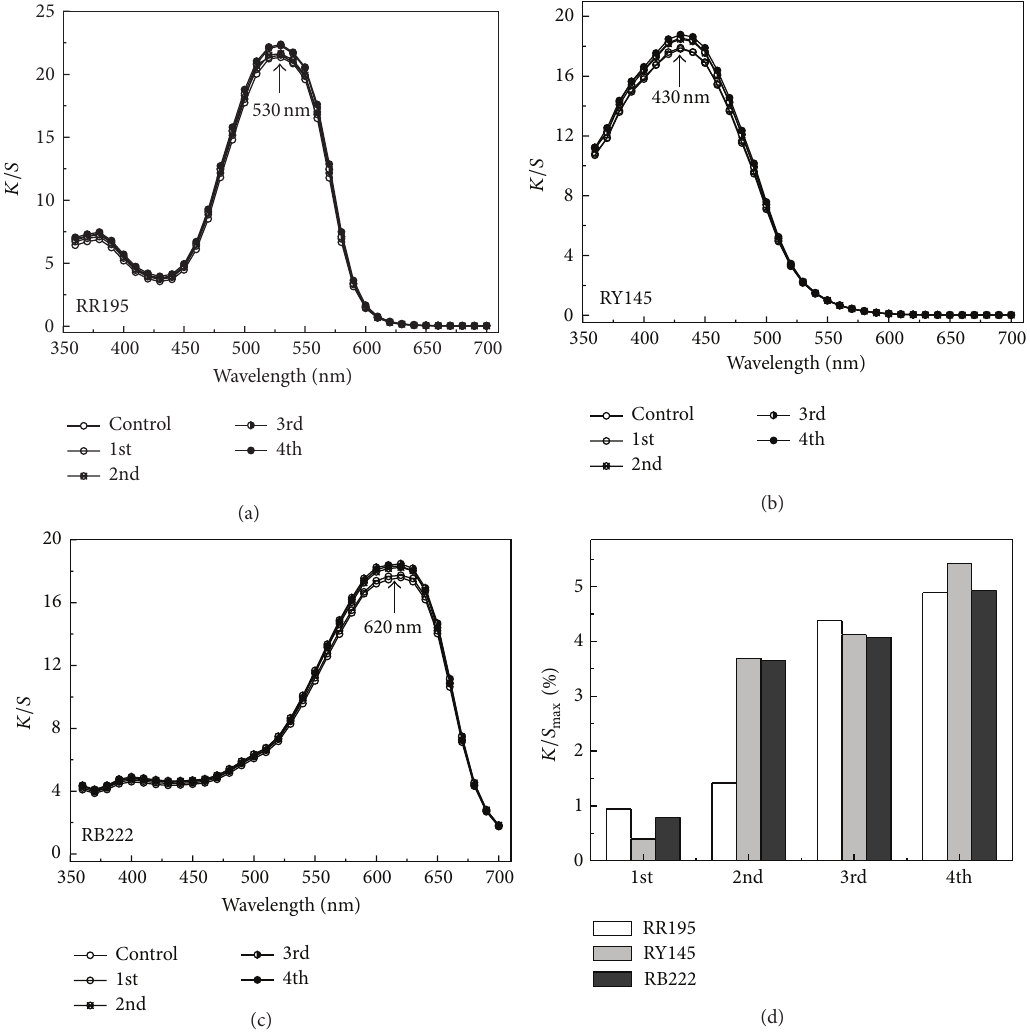
Figure 5: 𝐾/𝑆 curves and 𝐾/𝑆 max % values of three dyed cotton fabrics compared to control